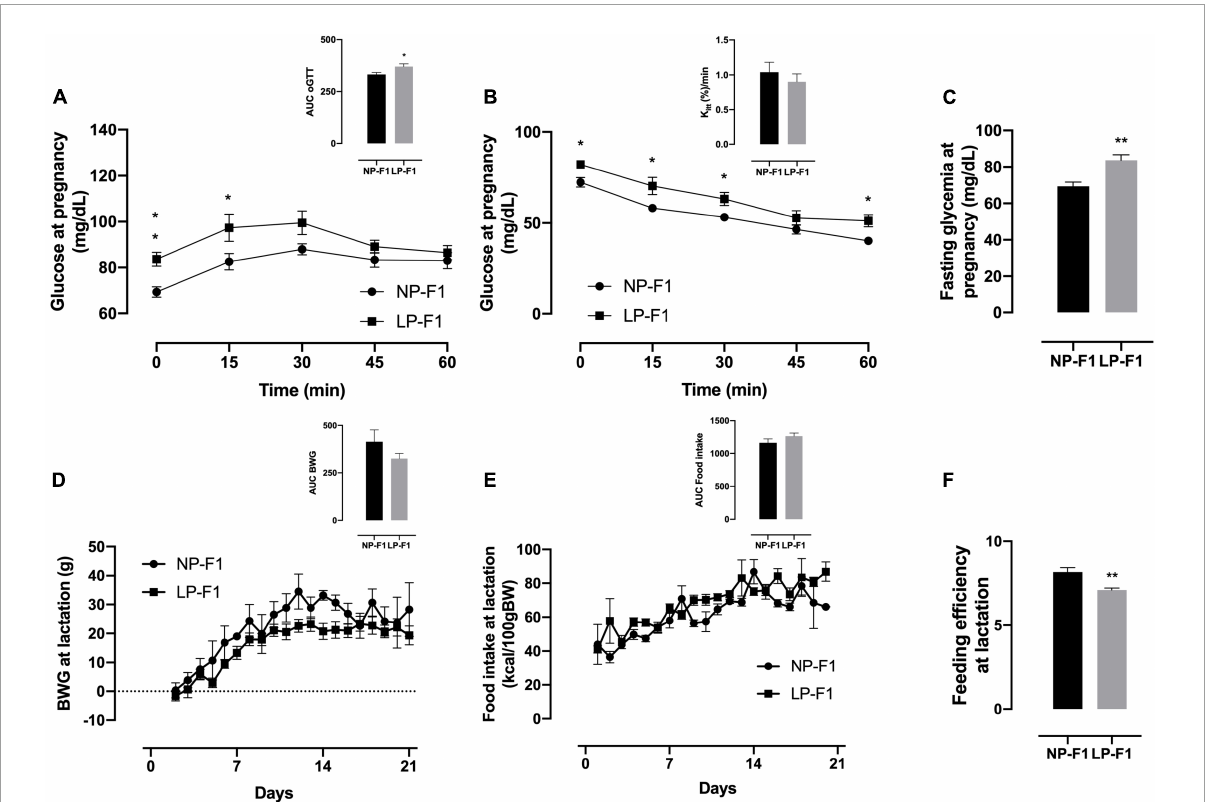
FIGURE2 Dams’ biometric parameters and glucose homeostasis analysis. Plasma glucose during oral glucose tolerance test (A) , insulin tolerance test and K itt (B) , and fasting glycemia (C) , during pregnancy; body weight gain (D) , food intake (E) , and feeding efficiency (F) during lactation. The data are expressed as the means ± S.E.M. and were obtained from 6 to 12 dams (from 6 to 12 different litter). The inset represents the AUC. * p < 0.05, ** p < 0.01 for Student’s t -test. NP-F1, female rats of dams fed a normal-protein diet during lactation; LP-F1, female rats of dams fed a low-protein diet during